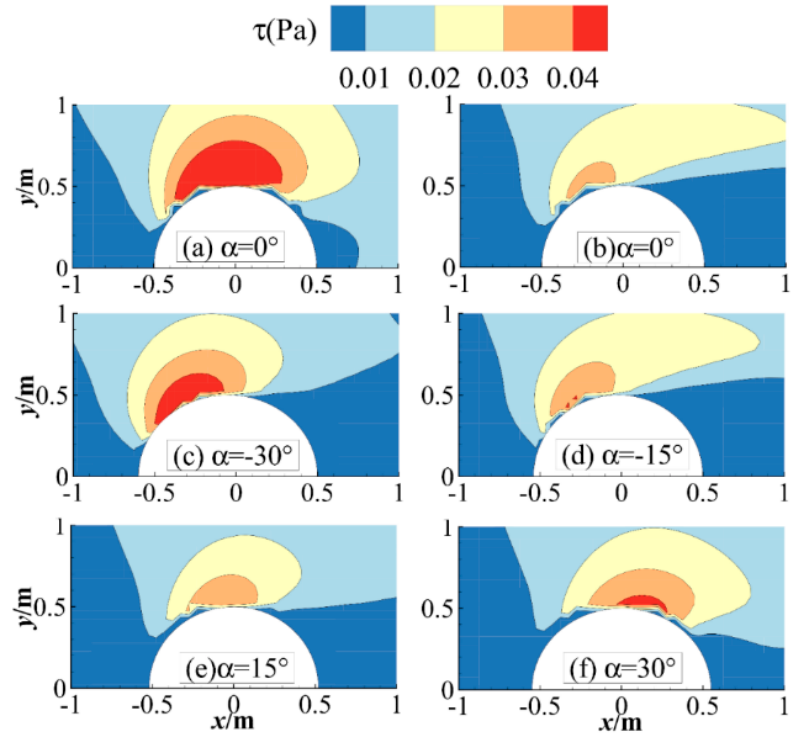
Figure 13. The distribution of the bed shear stress, ( a – f ) represents Case 1 to Case 6 in Table 2, respectively.